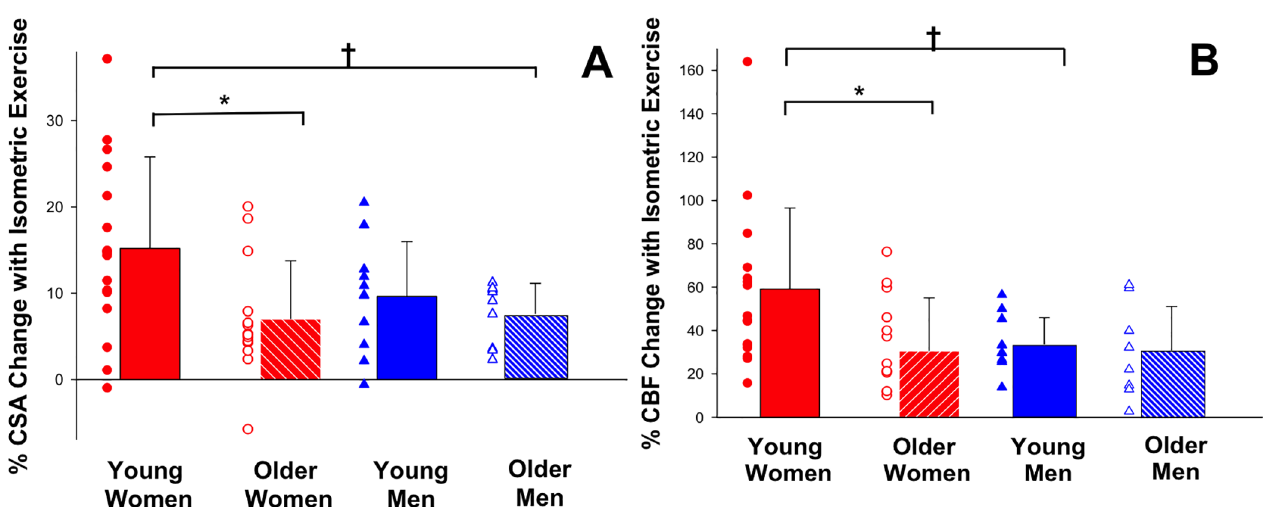
Fig 2. Change in coronary cross sectional area and blood flow with isometric handgrip stress(IHE). (A) Individual data points of relative changesin coronary vasoreactive parameters with IHE are shown for healthysubjects of both sexes (by age < 50 years and (cid:21) 50 years) for % CSA (coronary cross sectionalarea) in responseto IHE. Bars represent mean +/- SD. There was a significantdifference in %CSA changebetween healthyyoung and healthyolder women and men ( * p = 0.03, †p = 0.05). (B) Individual data points of relative changesin coronary endothelial function are shown for healthy participants groupedby age and sex for % CBF (coronaryblood flow) changein response to IHE. Bars represent mean +/- SD. The %CBF changefor healthy youngwomen was significantly highercomparedto healthyolder women and healthy youngmen ( * p = 0.02 †p =